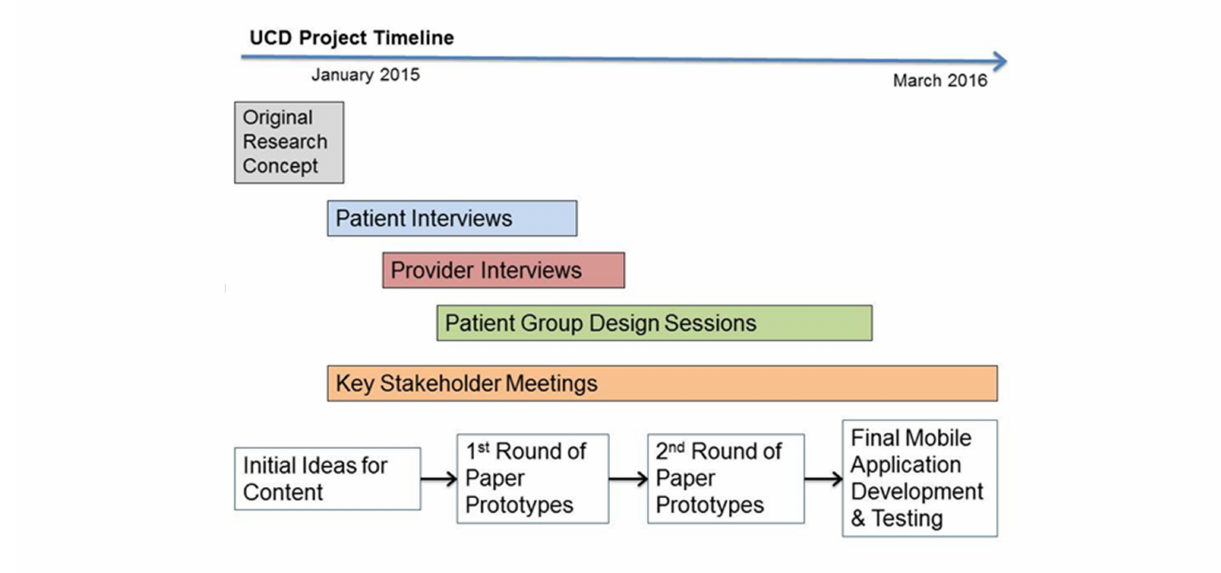
Figure 1. Stages of the user-centered design